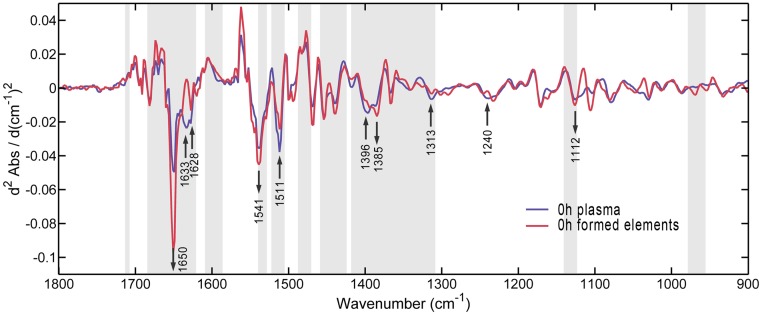
Comparison of spectra of 0-h plasma and formed elements.Arrows denote the spectral differences at corresponding bands in Fig 2B and point the direction from 0-h plasma to formed elements. Informative spectral subsets selected most frequently by GA-PLS (greater than 50%) are represented in gray, and others are in white.